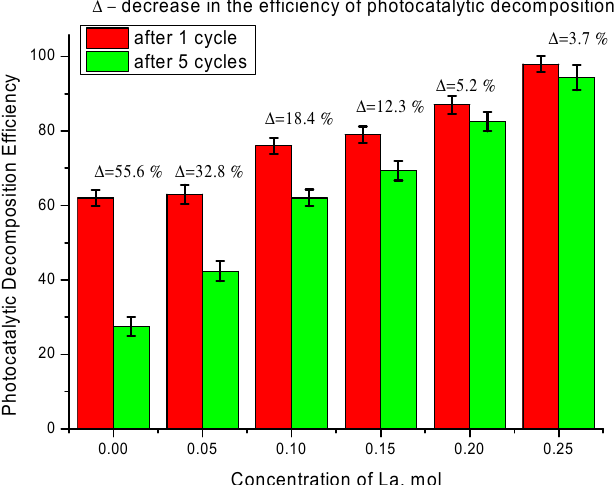
Figure 8. Results of evaluating the efficiency of photocatalytic activity after 1 and 5 cycles of successive reactions.